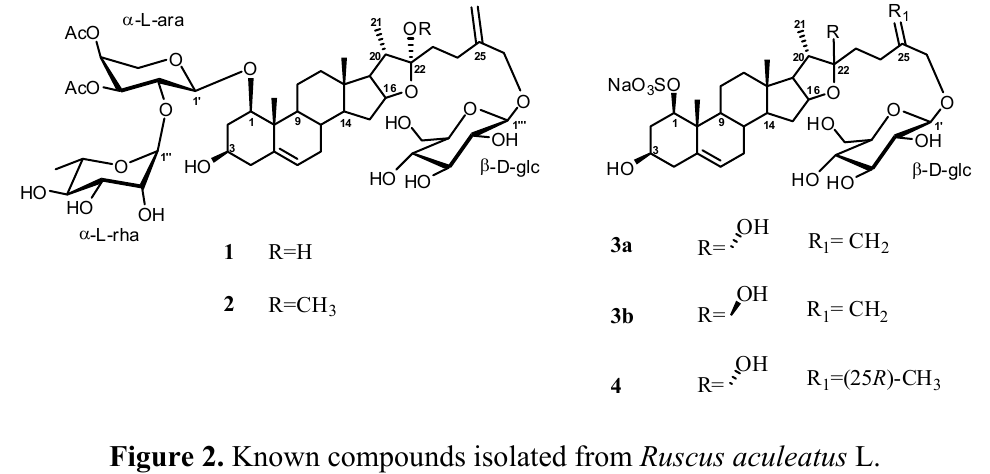
Figure 2. Known compounds isolated from Ruscus aculeatus